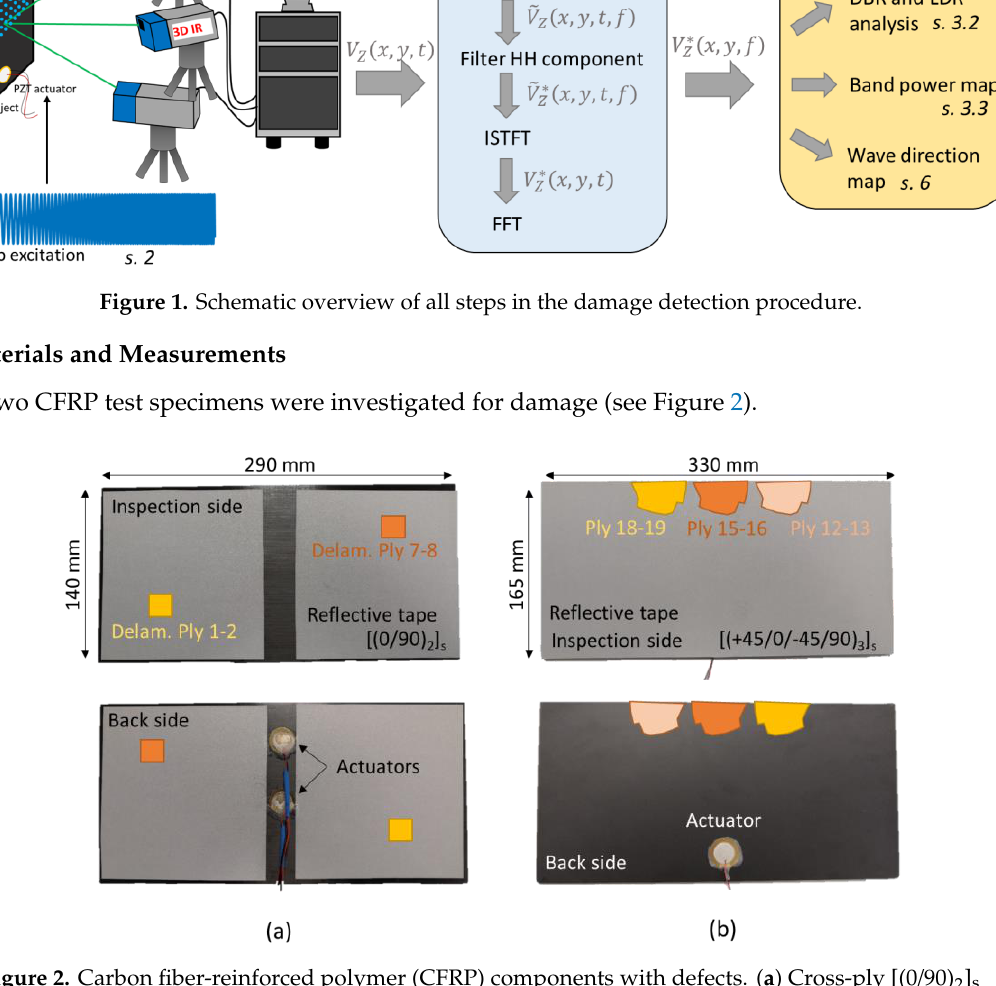
Figure 2. Carbon fiber-reinforced polymer (CFRP) components with defects. ( a ) Cross-ply [(0/90) 2 ]